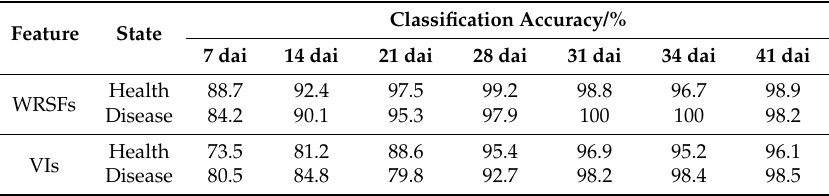
Table 8. Classification accuracy of healthy and diseased area of leaves based on Headwall hyperspectral